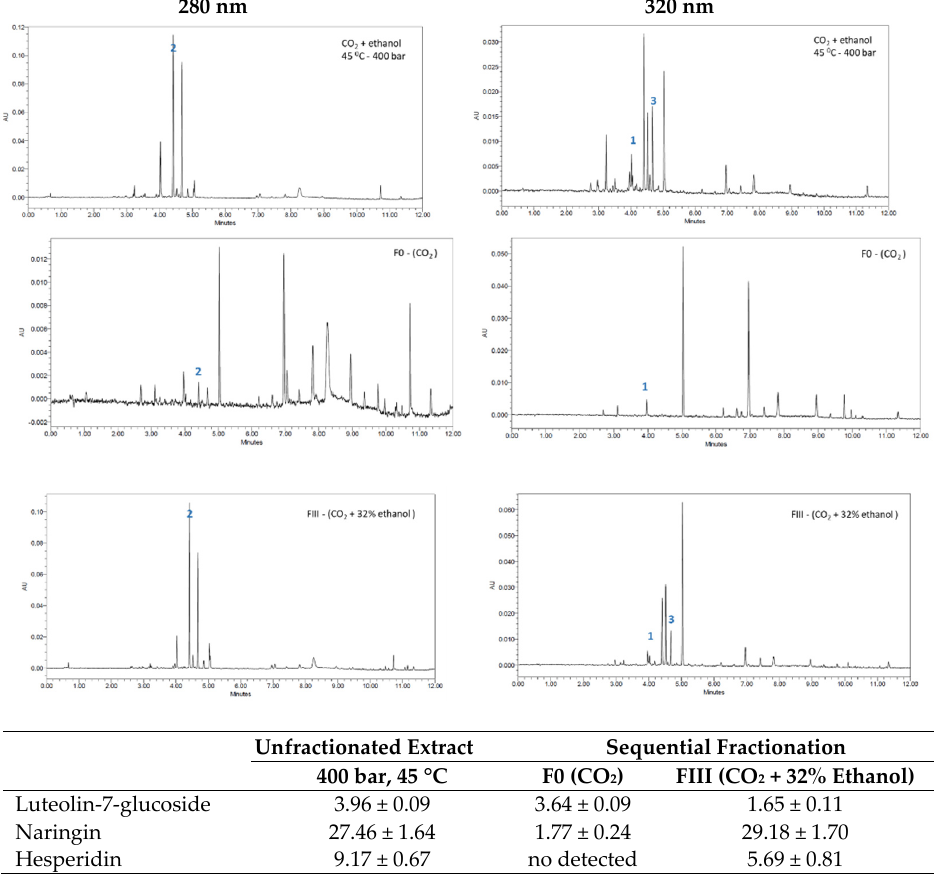
Figure 5. Chromatograms of the extract obtained at 45 °C and 400 bar, and of the fractions F0 and FIII. The table shows the percentage of each compound in the extracts or fractions with 95% confidence intervals.